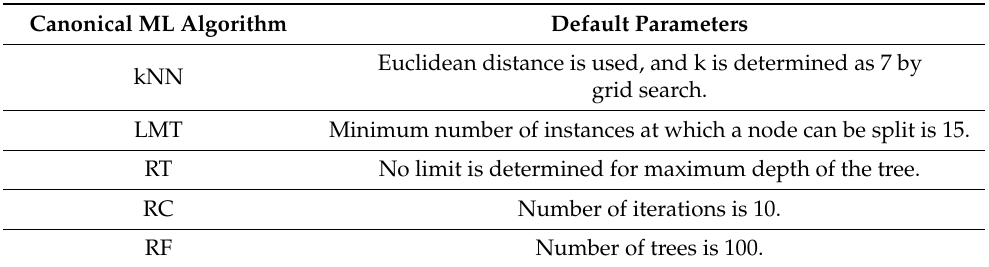
Table 1. Default parameters for ML algorithms. (Illustrations by the authors).